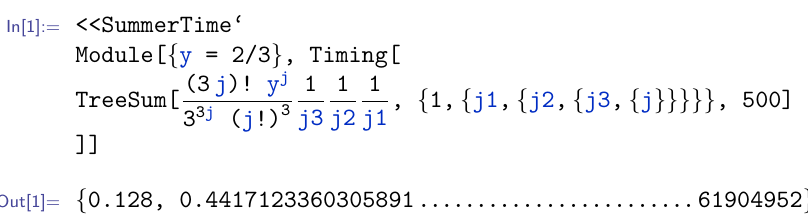
Figure 2 . SummerTime code for calculation of H (cid:11); 1 ; 1 ; 1 ( y ) at y = 2 =